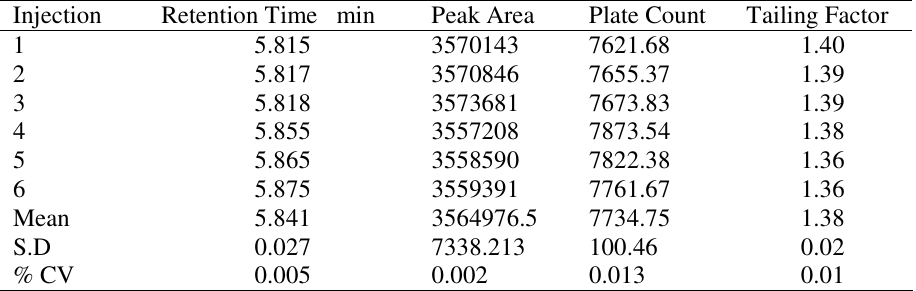
Table 1 . System suitability study of